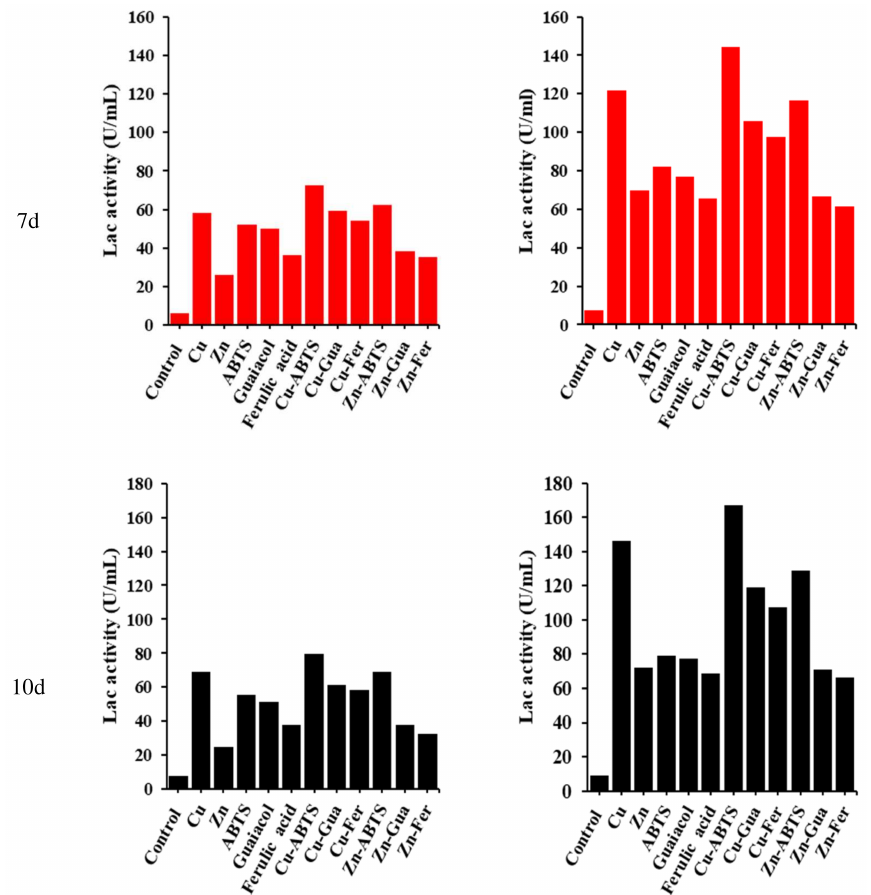
Figure 1. Time course of laccase activity monitored in MSM medium with five inducers (individual and combined) (control) and same medium, conditions 1% crude oil and same inducers (treatment).